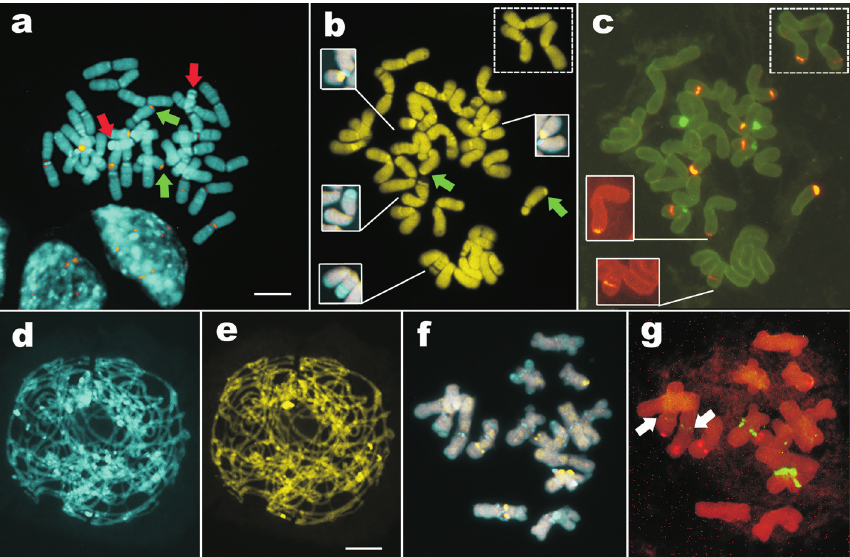
Figure 3 - CMA/DAPI bands and rDNA sites in Cuscuta indecora . (a) Metaphase showing merged DAPI and CMA images (red arrows = terminal DAPI bands; green arrows = terminal CMA bands). (b, c) Metaphase with CMA bands (b) and 5S (orange) and 35S (green) rDNA sites (c). Three chromosomes wereoutsidethepicture(dashedsquare).Insetsin(b)showchromosomepairwithproximalsecondaryconstriction(up)andterminalDAPIbands(down) and in (c) show weak sites. Green arrows in (a) and (b) point to CMA + bands co-localized with 5S rDNA sites. (d, e) Zygotene stained with DAPI (d) and CMA(e).(f,g)Diakinesisshowingmainbands(f)andrDNAsites(g)withtwoweak35SrDNAsites(whitearrows).Barin(a)correspondsto10 (cid:3)